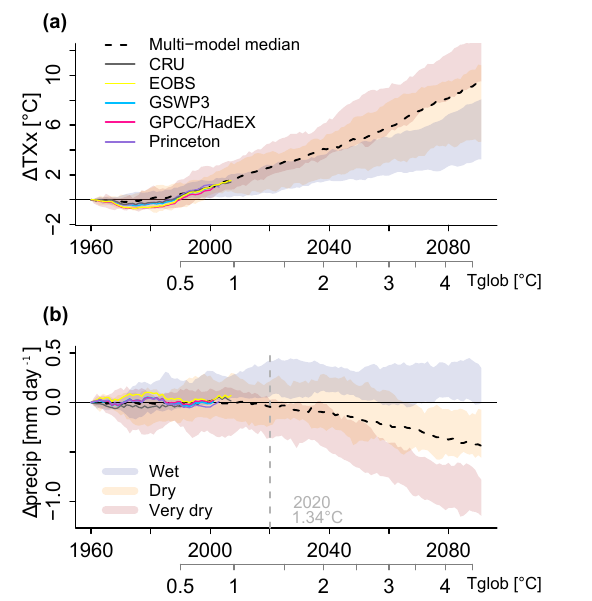
Figure 4. Changes in (a) TXx and (b) summer precipitation (pre- cip) in CEU. The multi-model mean median (dashed black) of the whole ensemble is shown. The shaded area shows the minimum and maximum from the wet (blue), dry (orange) and very dry (red) models. The gray lines show changes of CRU, EOBS, GSWP3, GPCC/HadEX and Princeton (20-year means) from 1950 to 1969 until the end of the observed time periods which ranges from 2010 to 2016. The gray vertical line indicate from where the distributions of precipitation for the very dry and wet models do not